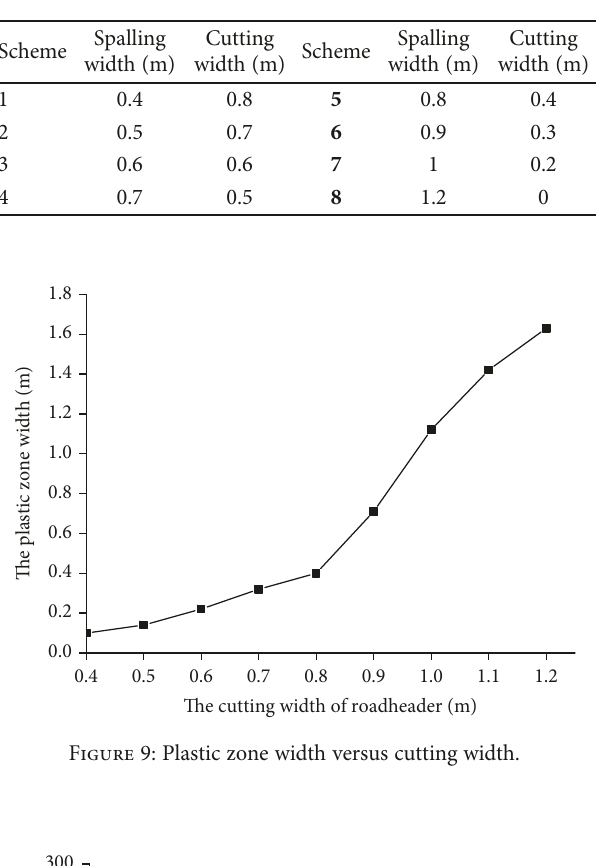
Table 3: Simulation scheme.